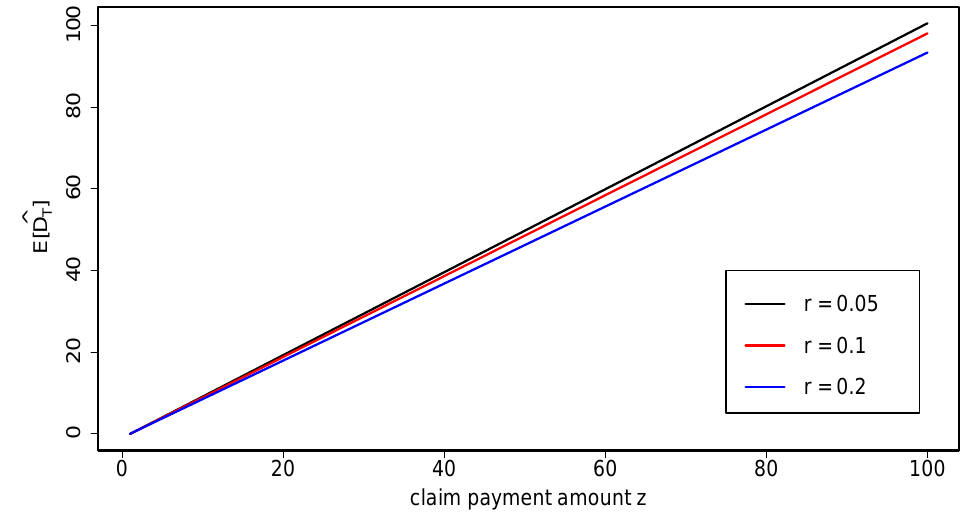
D T ] are displayed against the time horizon T , for (cid:98)